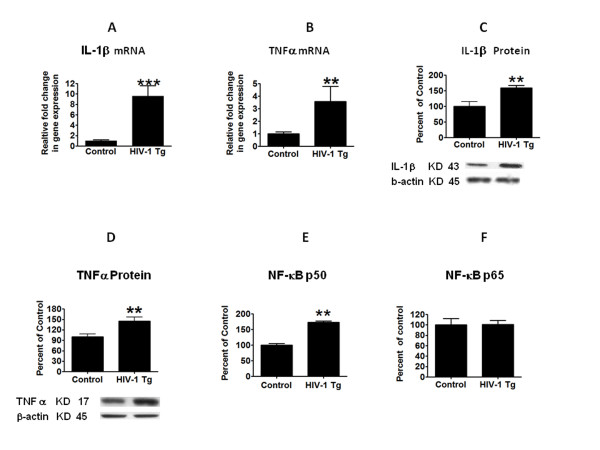
mRNA levels of brain IL-1β (A) and TNFα (B) in control and HIV-1 Tg rats, measured using real time RT-PCR. Data are levels of brain IL-1β and TNFα in the HIV-1 Tg rat normalized to β-globulin and represented relative to control level (calibrator) using the ΔΔCT method. Representative immunoblots of (C) IL-1β and (D) TNFα protein in control and HIV-1 Tg rat brain. Bar graphs are ratios of optical densities of immunoblots to β-actin, expressed as percent of control (mean ± SEM). Representative brain transcription factor binding activities (DNA-protein complex) of NF-κBp50 (E) and NF-κBp65 (F) in control and HIV-1 Tg rats. DNA binding activity was measured in brain nuclear extracts as described in Methods. Data represent mean ± SEM. Statistical significance: **p < 0.01, ***p < 0.001 as determined by unpaired t-test.